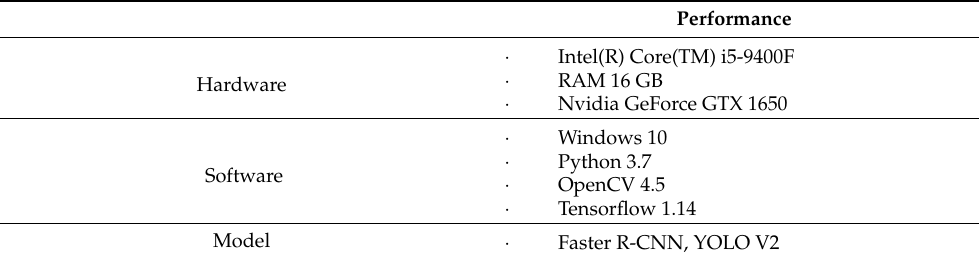
Table 4. Analysis Environment.